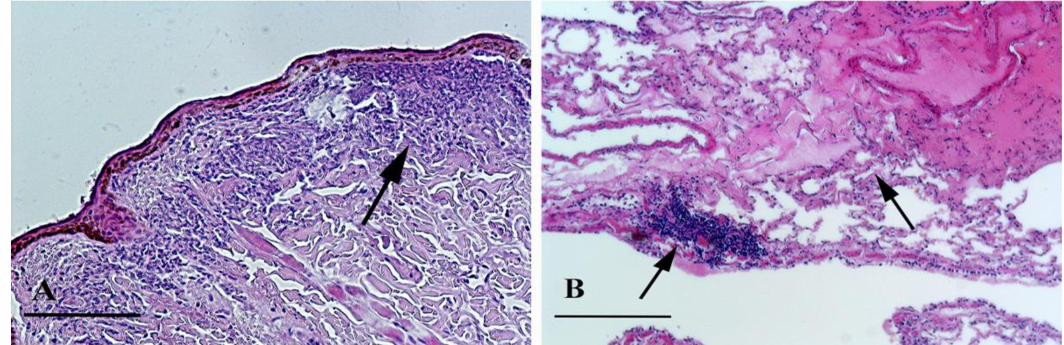
Figure 4. Nasal sinuses. ( A ) Inflammatory infiltrator (arrow). H&E staining, bar = 100 µ m; ( B ) Inflammatory infiltrator and edema (arrows). H&E staining, bar = 100 µ